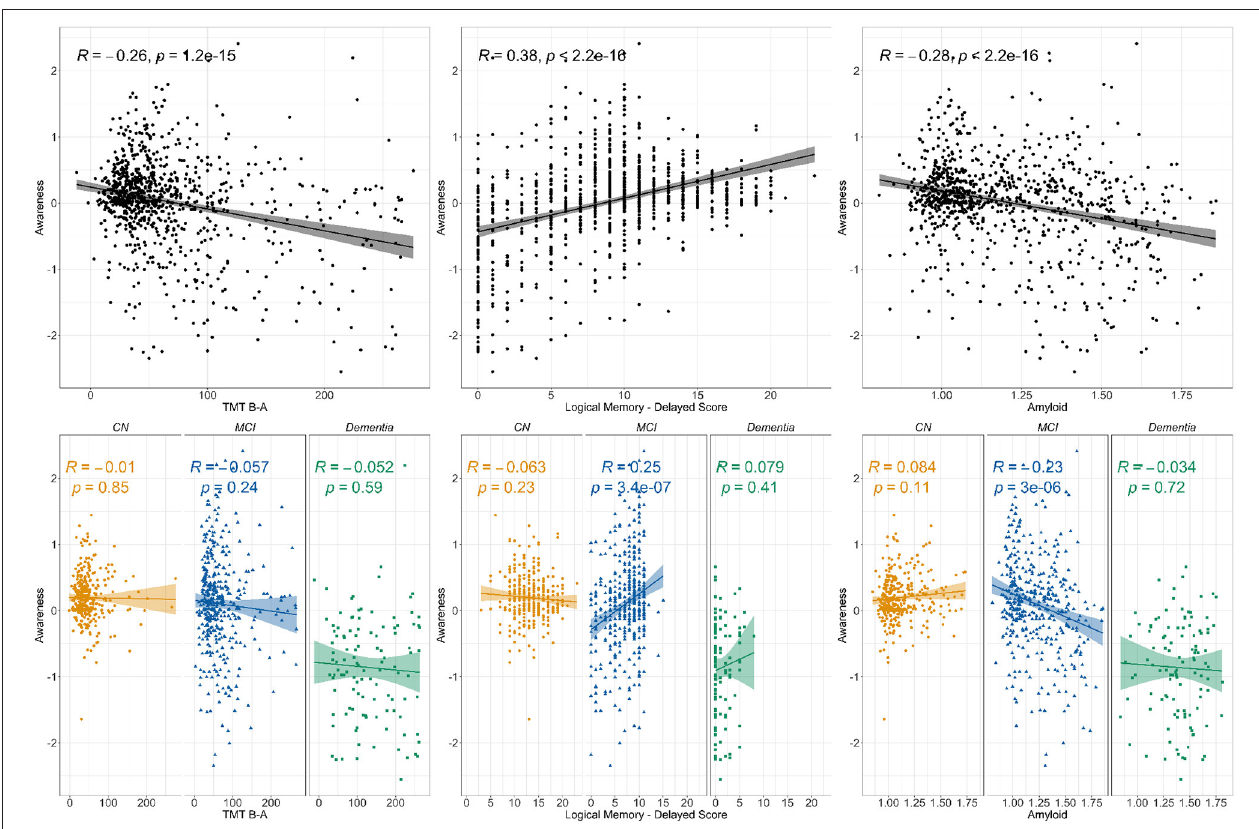
FIGURE 1 | Correlations between awareness and TMT B-A, Logical memory delayed score and amyloid. Notes: The figure presents the Pearson correlation coefficient for the relationship between awareness and cognition (Trail Making Test B-A for executive function and Logical Memory’s delayed recall for episodic memory) as well as amyloid (SUVr). The top line presents the correlations for the whole sample while the bottom line displays clinical groups correlations. Three clinical groups are represented, i.e., Cognitively Normal (CN), Mild Cognitive Impairment (MCI), and participants diagnosed with